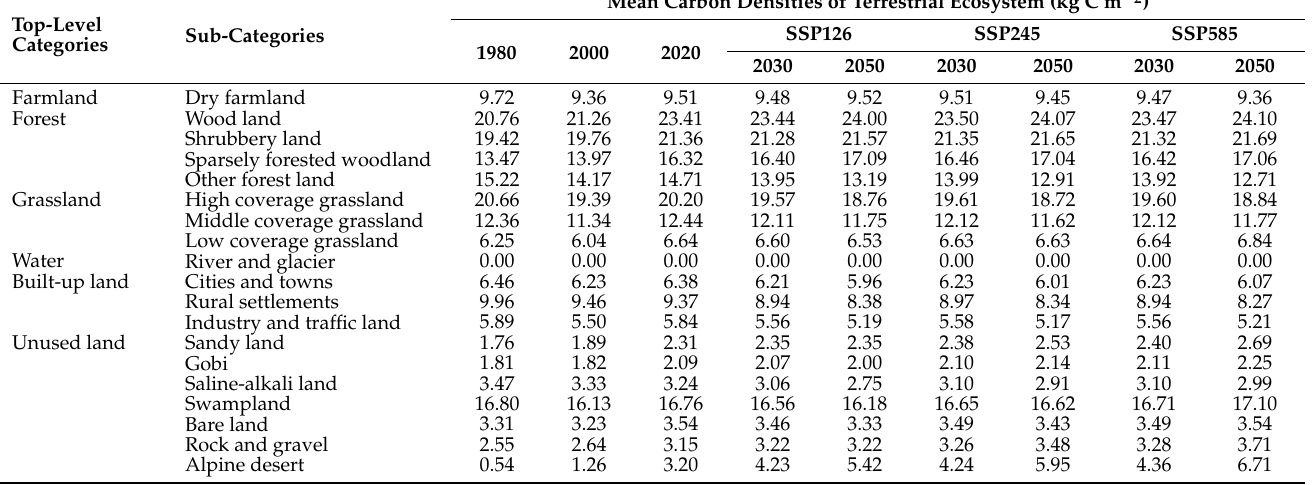
Table 2. The mean carbon densities of terrestrial ecosystem across the Gansu province of historical periods (1980, 2000, and 2020) and future periods (2030 and 2050) under SSP126, SSP245, and SSP585 scenarios. Note: SSP represents the shared socio-economic pathways in CMIP6